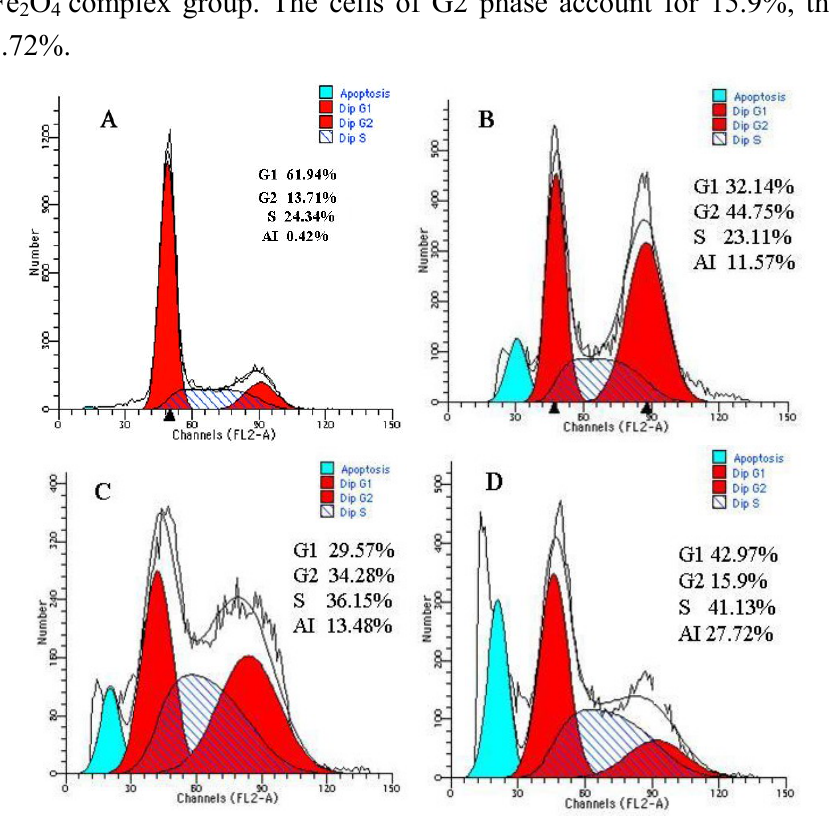
O /Mn Zn Fe O nanoparticles with MFH on 2 3 0.5 0.5 2 4